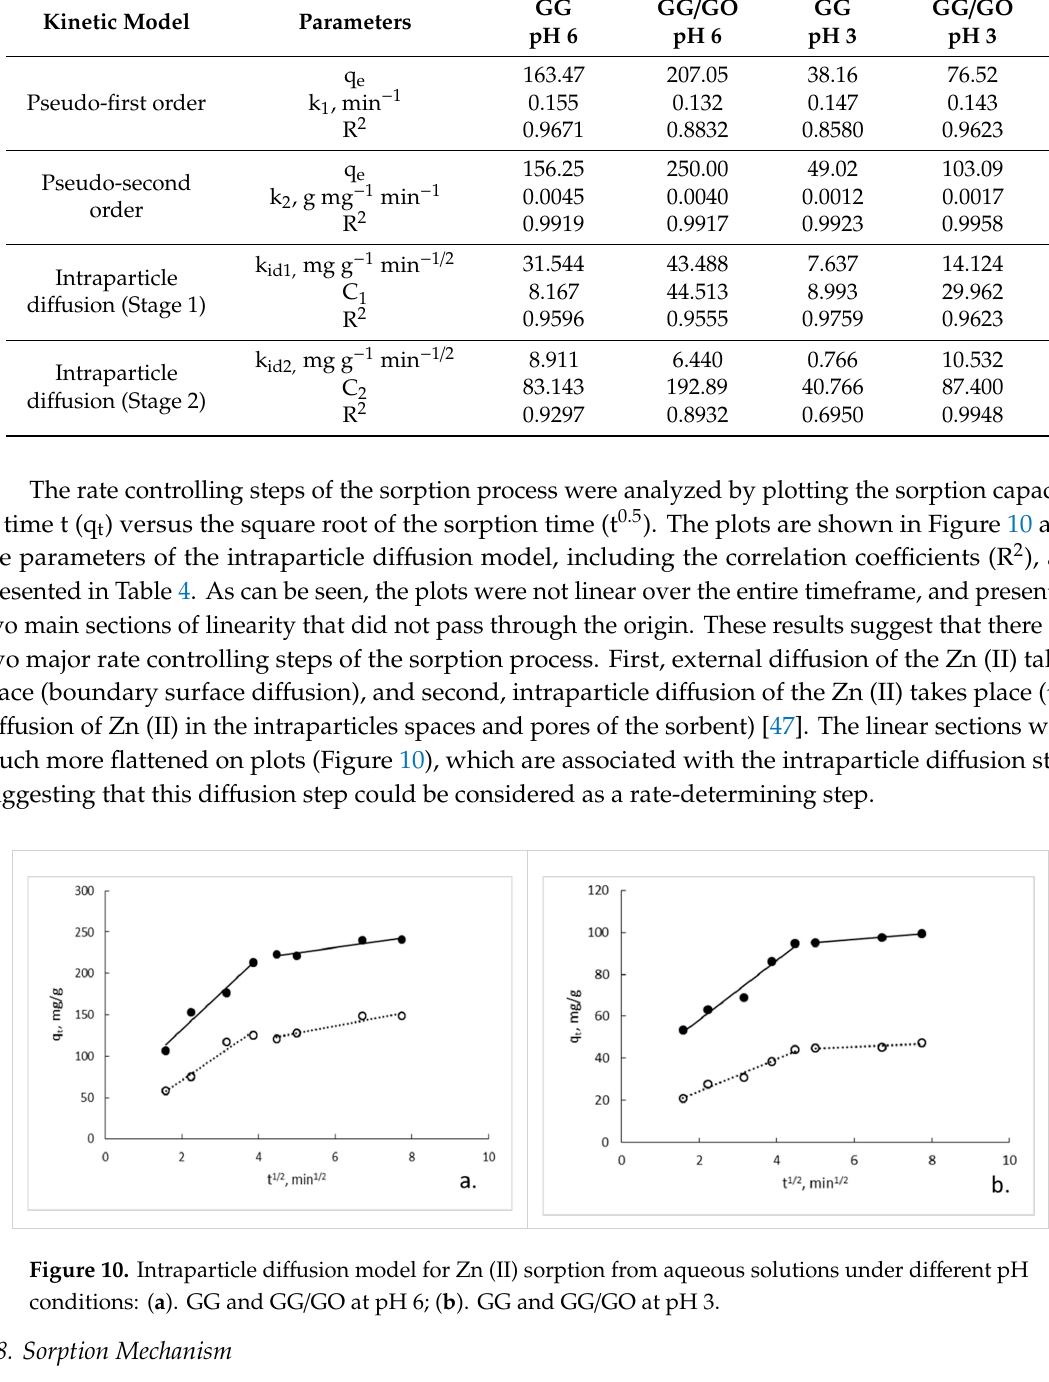
Table 4. Kinetic parameters and the correlation coe ffi cients of Zn (II) sorption on GG and GG / GO.